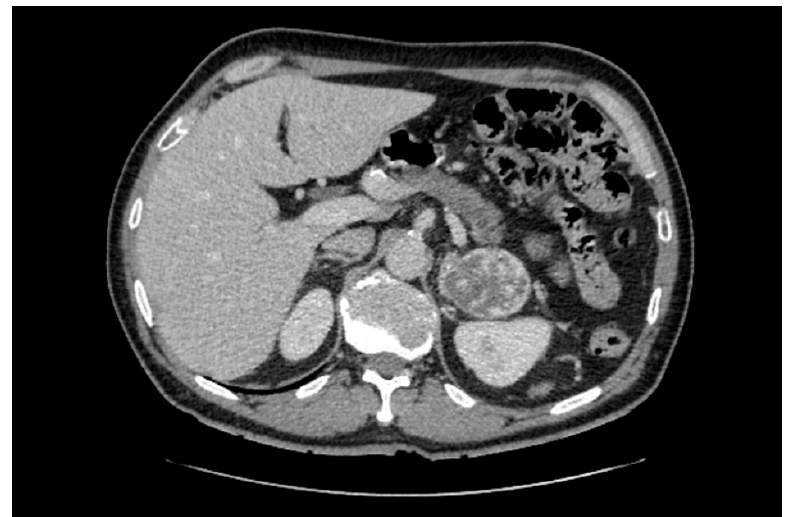
Figure 2. Computed tomography displaying a 6 × 5 cm large, well-defined and heterogenous-appearing pheochromocytoma originating from the left adrenal gland. The right adrenal gland is normal.